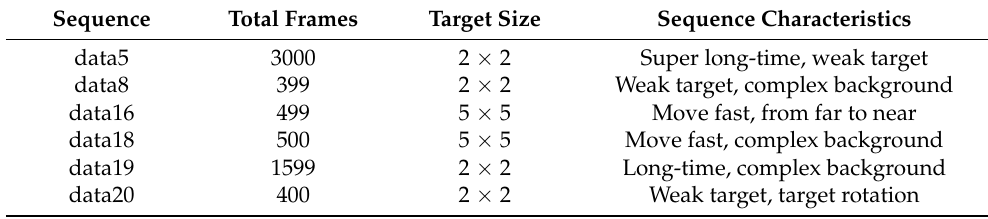
Table 1. Detailed description of six groups of sequences.